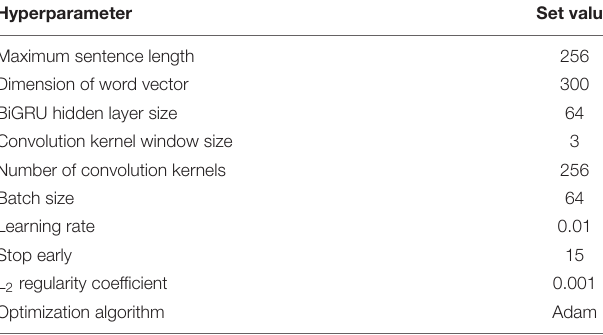
TABLE 3 | Hyperparameter settings of this